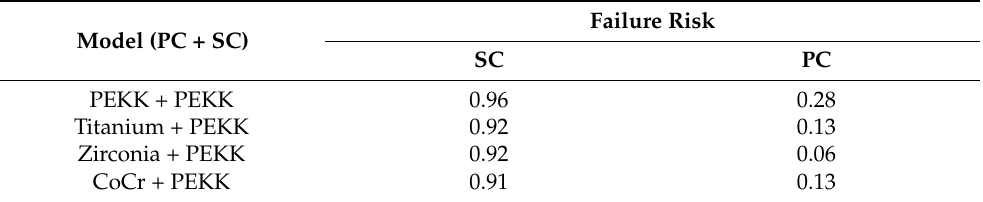
Table 4. Failure risks for primary and secondary crown according to the different materials combination. Model (PC +